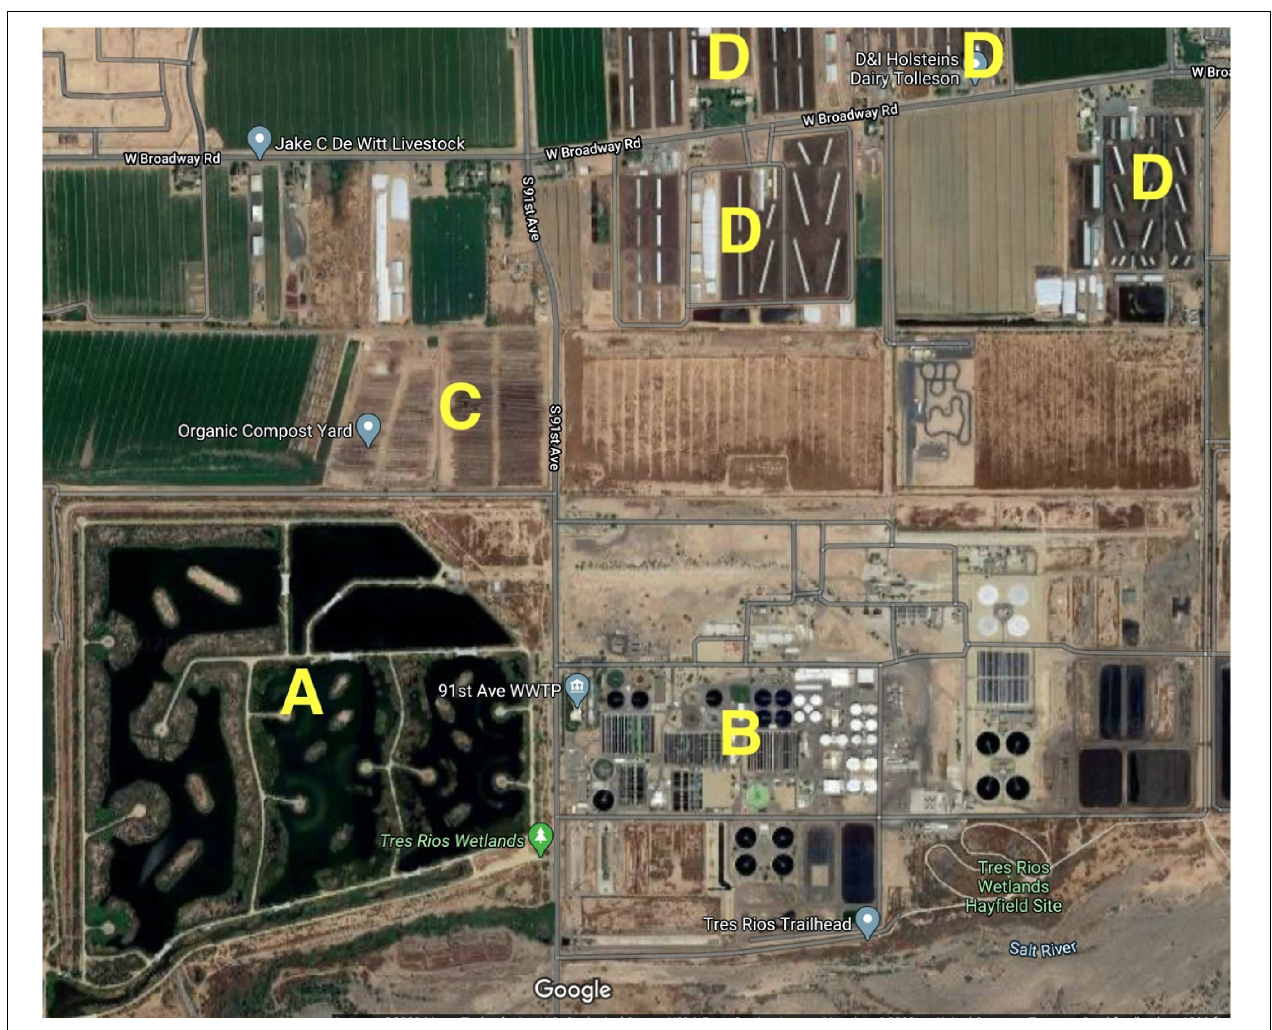
FIGURE 6 | Aerial view of the vicinity around the Tres Rios CTW. (A) The Tres Rios CTW; (B) the City of Phoenix 91st Avenue wastewater treatment plant; (C) the large manure composting facility immediately north of the CTW (the tightly stacked horizontal lines in the image are piles of composting manure that are 2–3 m tall); (D) several concentrated animal feeding operations (CAFOs) nearby which are the source of the manure being composted (image from Google